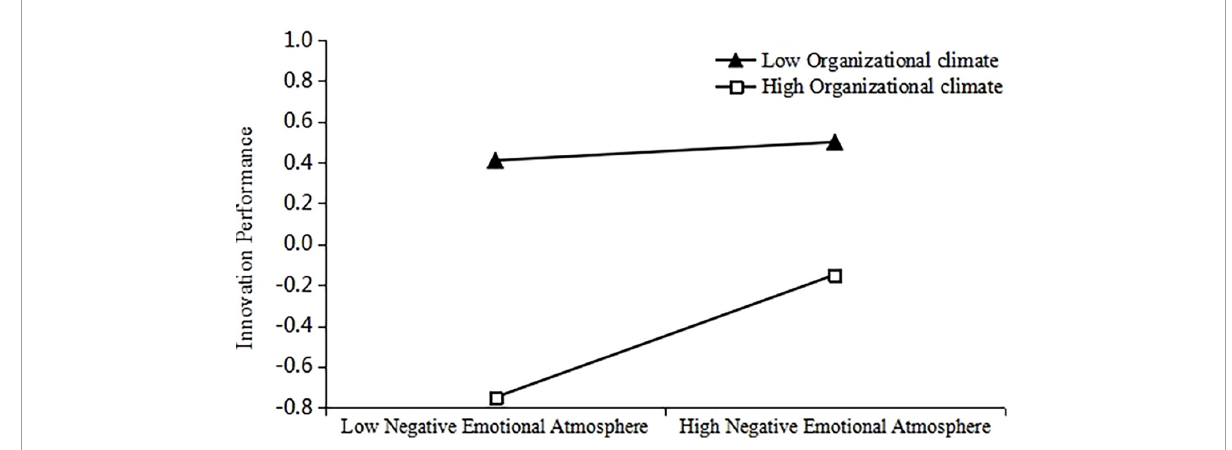
FIGURE3 The moderating role of organizational climate on the relationship between negative emotional atmosphere and innovation performance.